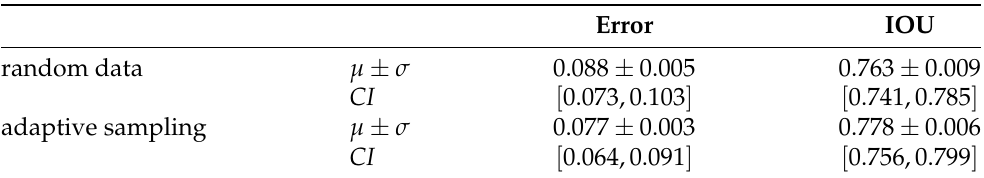
Table 2. Evaluation of the adaptive data generation and finetuning procedure. µ ± σ = mean error ± standard deviation, CI = 99% confidence